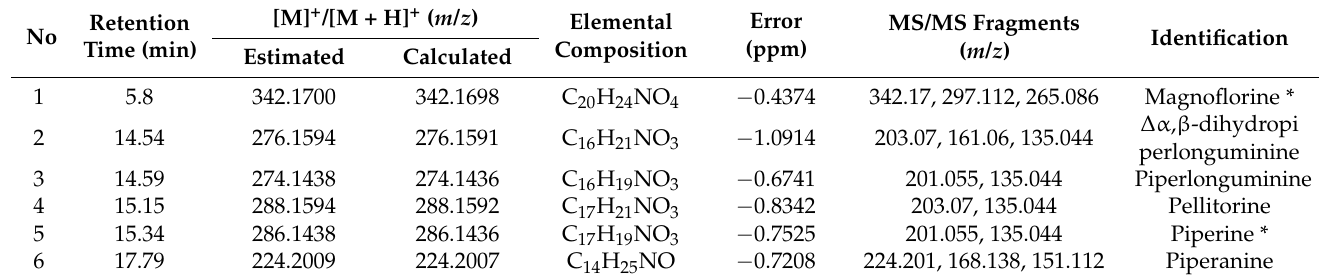
Figure 5. UHPLC–MS/MS analysis of WEPL. ( A ) Base peak chromatogram; ( B ) Extracted ion chromatogram of identified phytochemicals. Table 1. Identification of the phytochemicals in WEPL by UHPLC-ESI-MS/MS